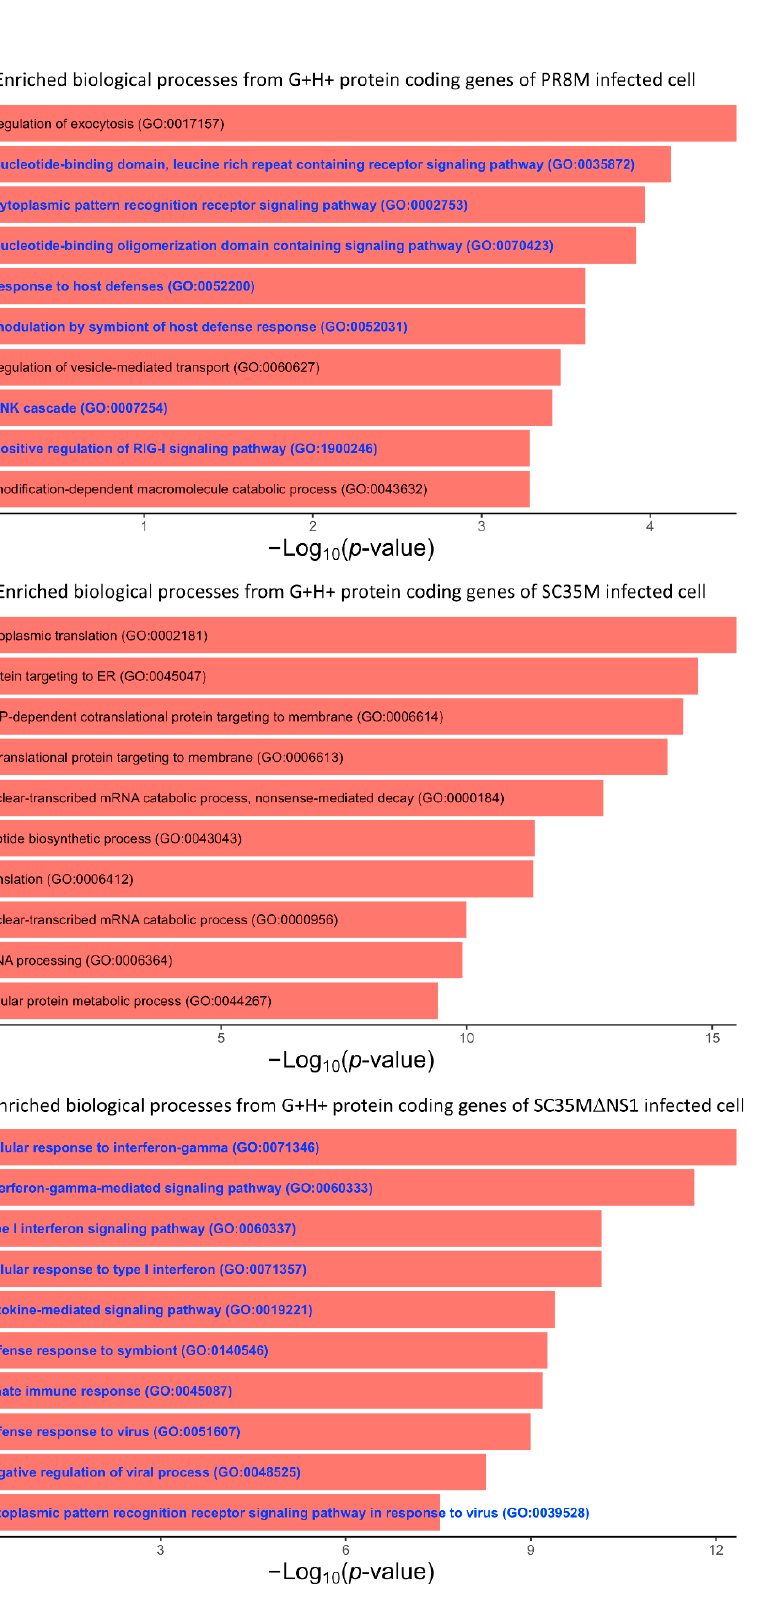
Figure 5. Top 10 most significantly enriched biological process GO terms associated with the protein-coding genes of the G+H+ DEHERV-G pairs. Terms are ranked according to the p -value. ( A ) PR8M infected cells, ( B ) SC35M infected cells, and ( C ) SC35M Δ NS1 infected cells. Go terms related to immune or inflammation processes are shown in blue color.